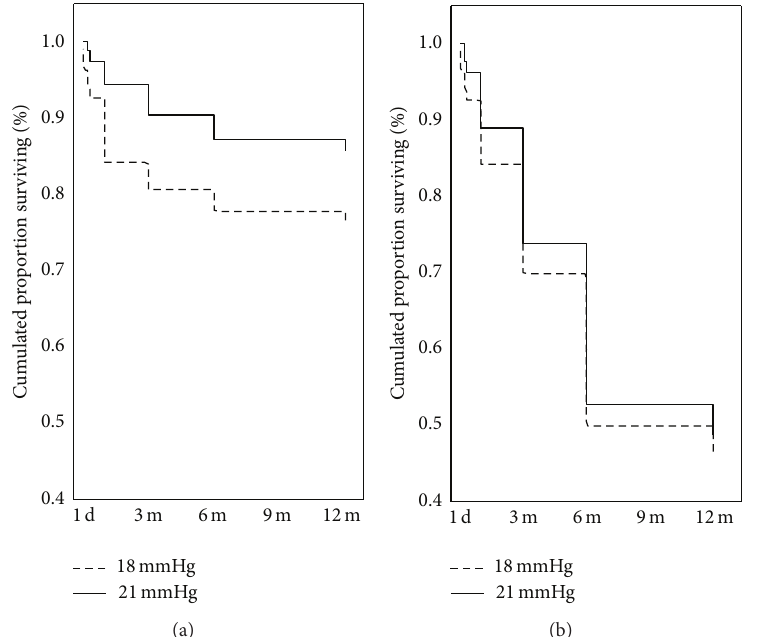
Figure 2: Cumulative surviving proportion (Kaplan-Meier) for success criterion of intraocular pressure less than or equal to 18 and 21 mmHg. (a) Qualified success rate (log-rank test; 2,004523, 𝑃 = 0.04501 ); (b) complete success rate (log-rank test; 0.7002498, 𝑃 = 0.48377